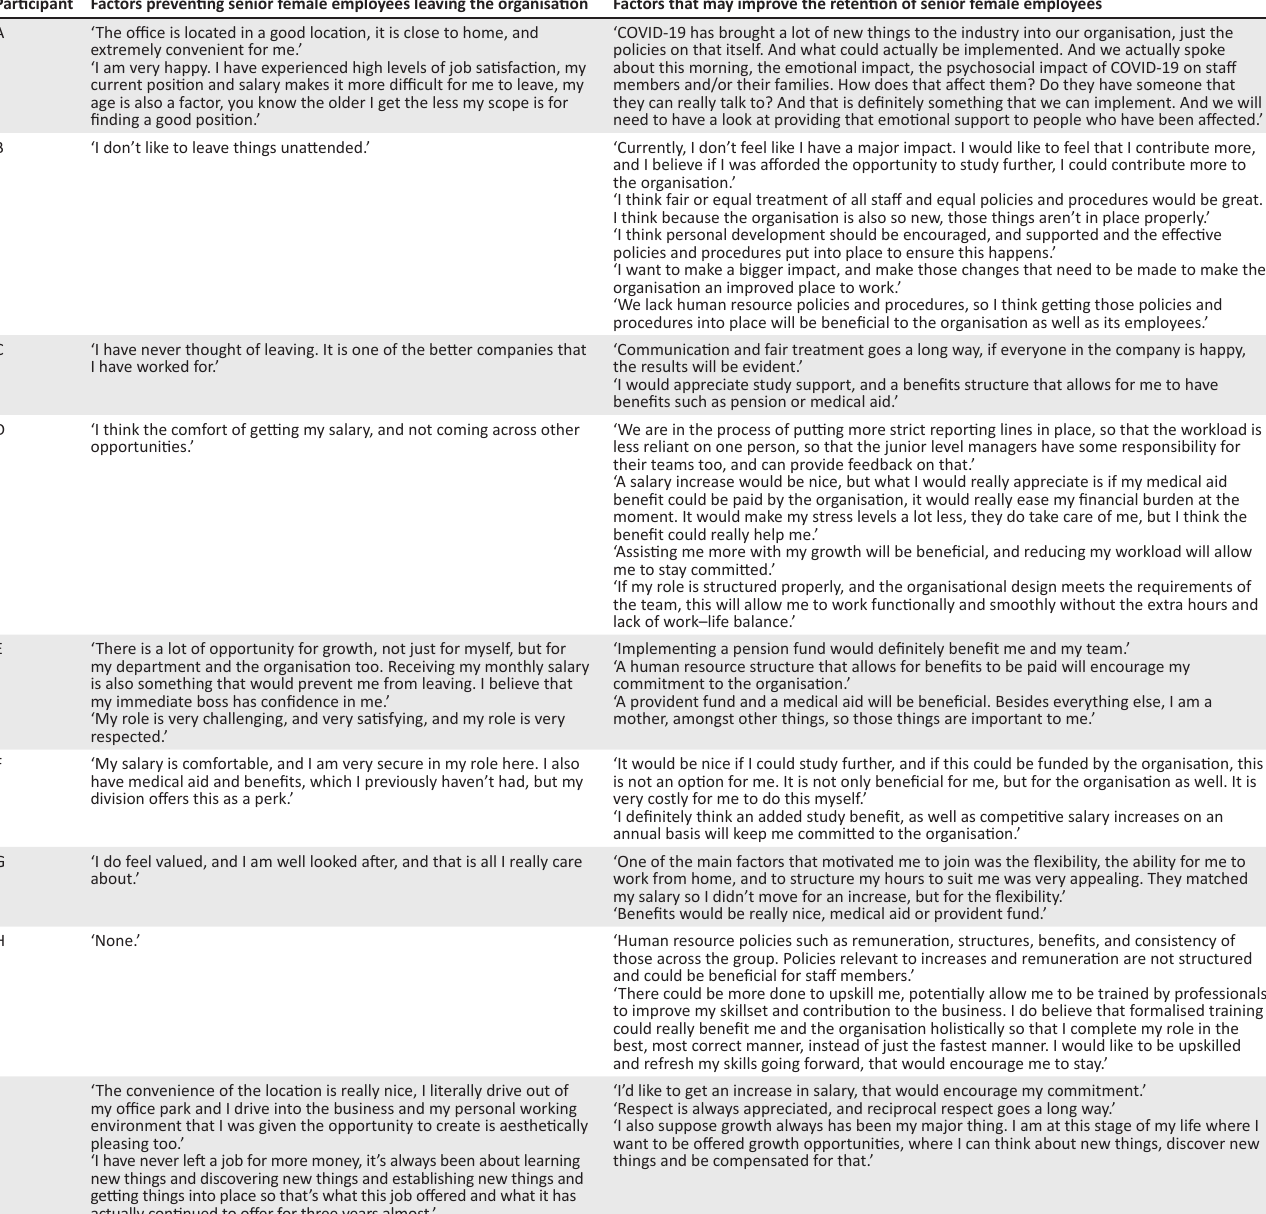
TABLE 3: Factors perceived as preventing senior female employees’ leaving and improving